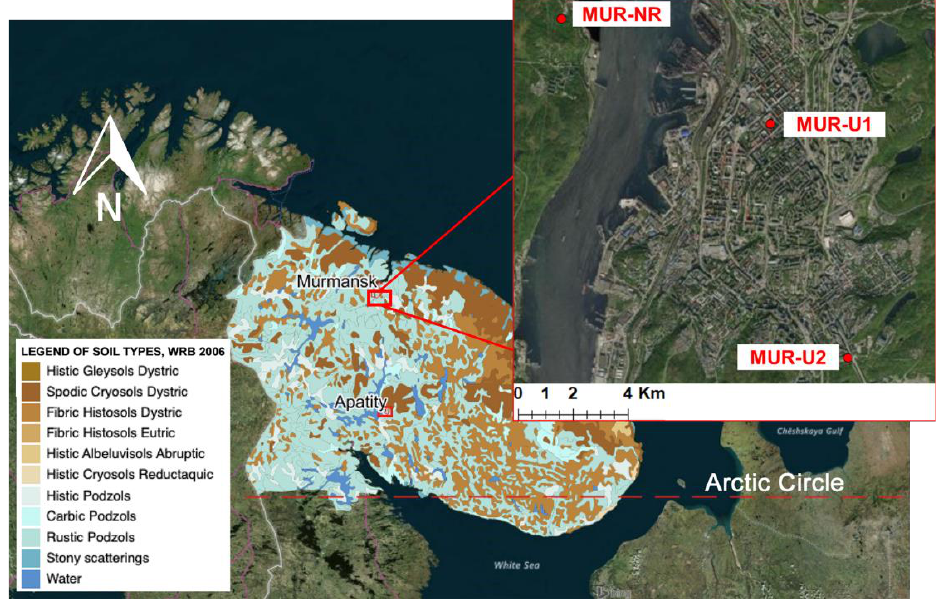
Figure 1. Research area and sampling scheme.